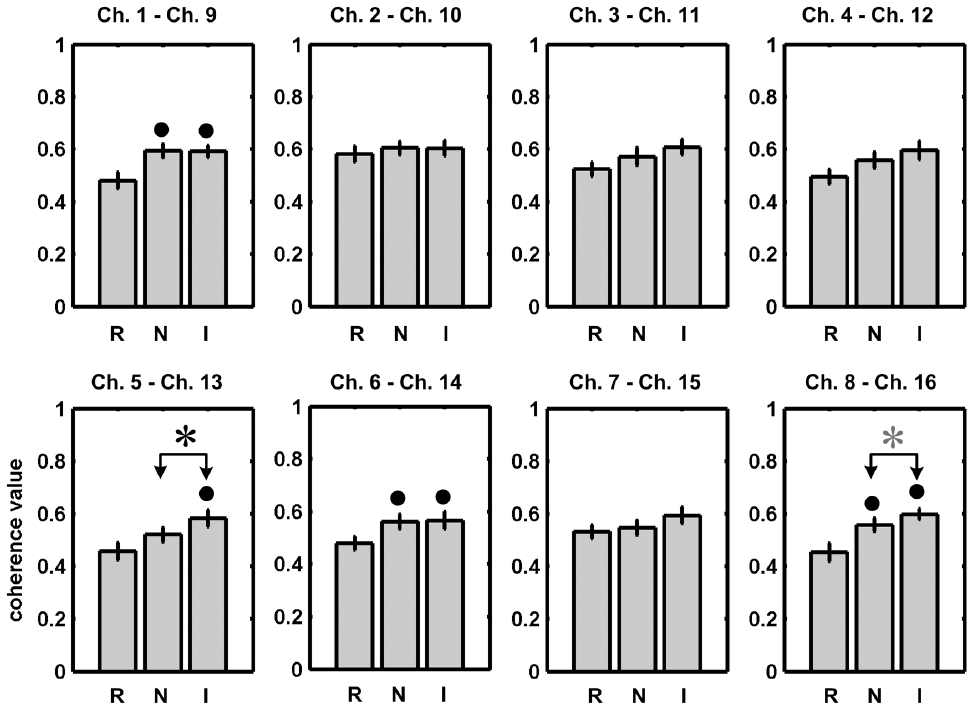
Fig. 5. Grand average coherence value of homologous channel pairs. Data are shown in mean (cid:1) SE. R, rest period; N, neutral task; I, Incongruent task. Signi¯cant di®erence between task and rest period is indicated by black dot ( p < 0 : 05). Signi¯cant di®erence between incongruent task and neutral task is indicated by black asterisk ( p ¼ 0 : 004) and marginally signi¯cant di®erence is indicated by gray asterisk ( p ¼ 0 :